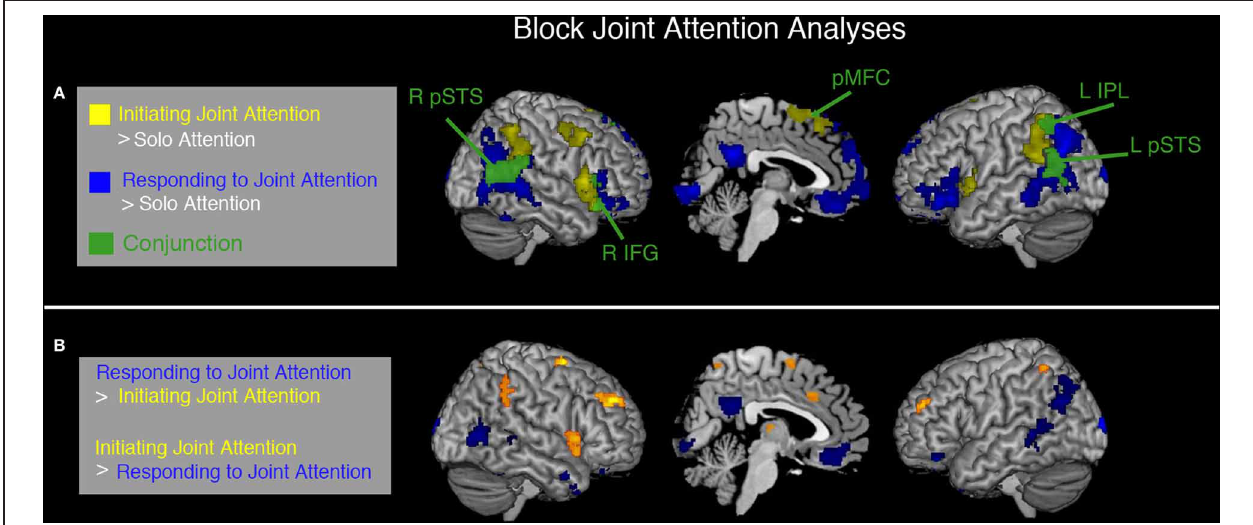
FIGURE 3 | Common and distinct regions for IJA and RJA identified by block analyses. Data are voxel- and cluster-corrected at p < 0 . 05. In (A) regions showing a significantly greater response during initiating joint attention (IJA) than Solo Attention (SA) blocks are shown in yellow, those showing a greater response during responding to joint attention (RJA) blocks than SA are shown in blue. Regions showing a significant